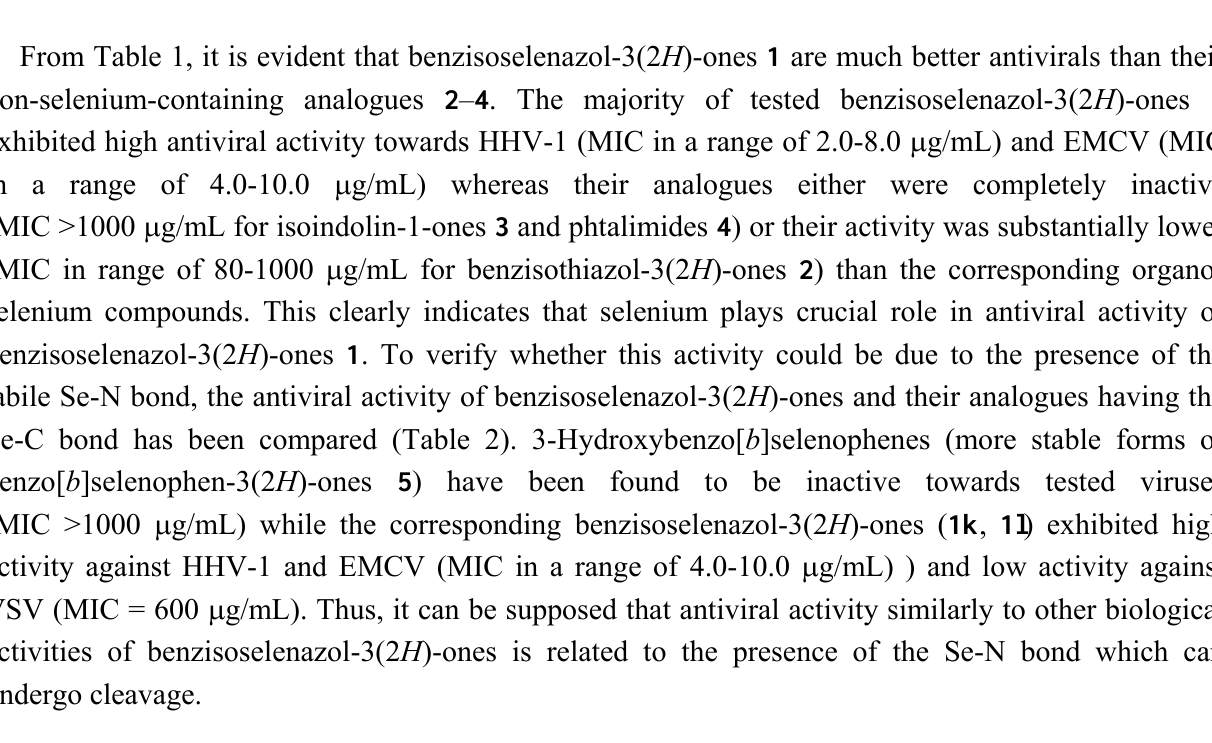
Table 2. Comparison of the virucidal activity of benzisoselenazol-3(2 H )-ones 1 and their analogues having the Se-C bond instead of the Se-N bond 5